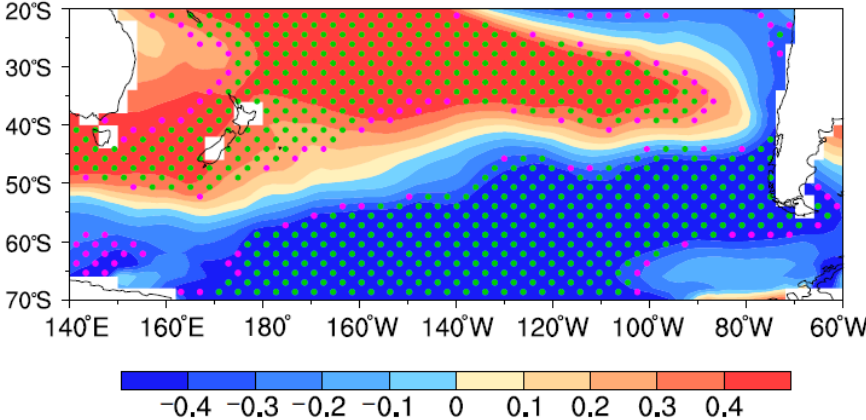
Figure 4. Correlation map between the autumn southern Pacific Ocean (SPO) dipole (SPOD) index (SPODI) and winter SST anomalies (SSTAs). The magenta and green stippled areas indicate statistical significance at the 90% and 95% confidence levels, respectively, with effective numbers of degrees of